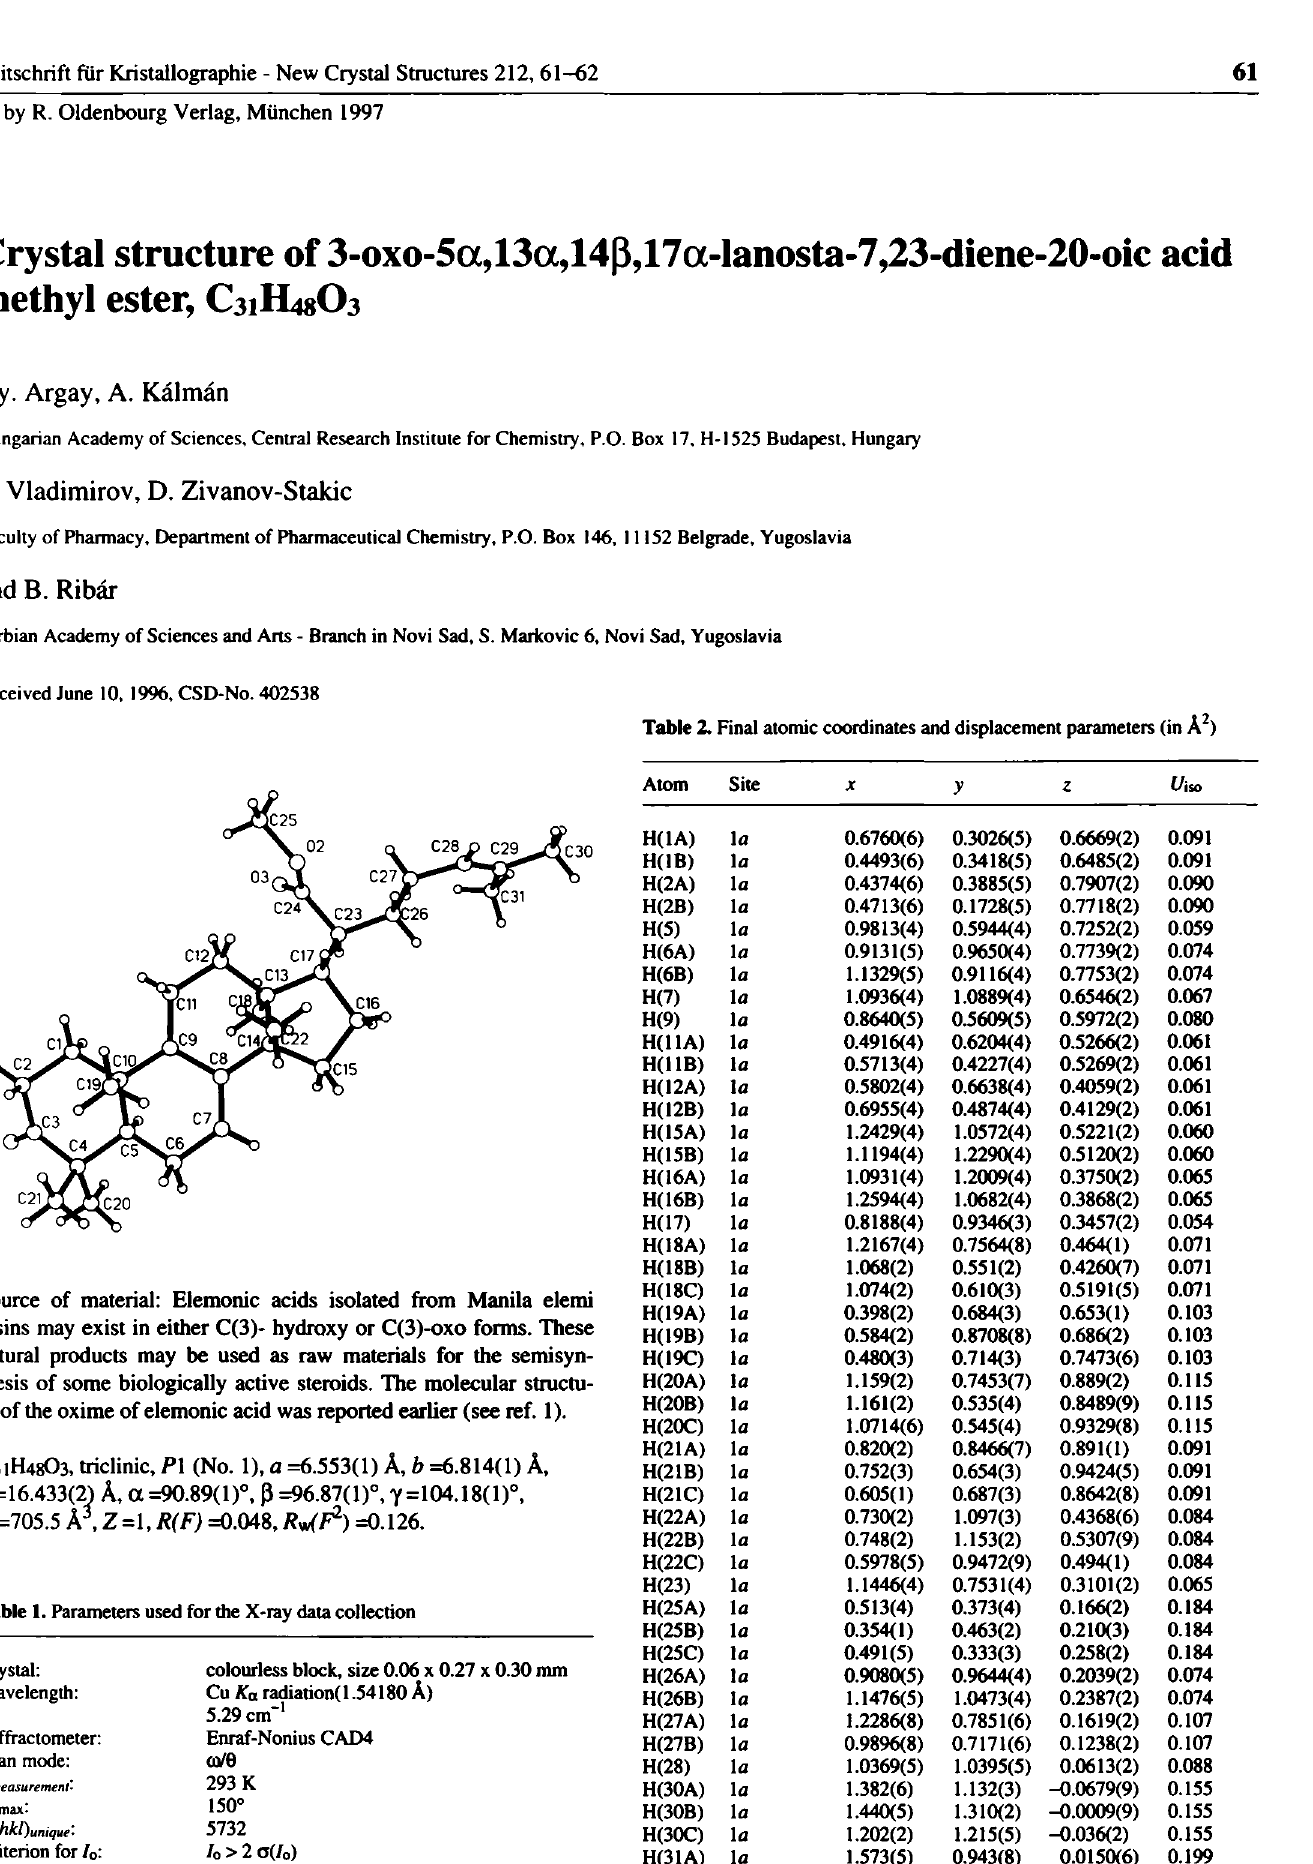
Table 1. Parameters used for the X-ray data collection Crystal: